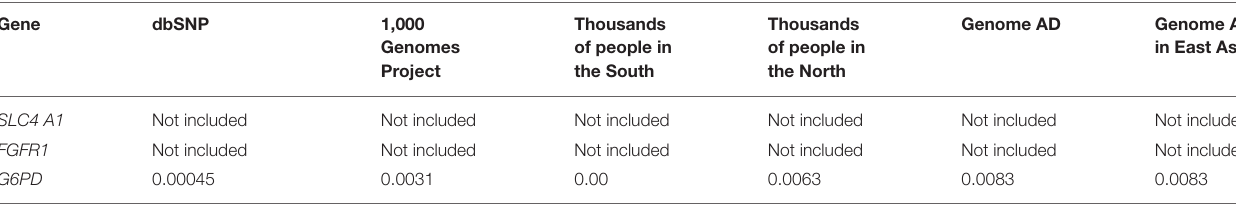
TABLE 4 | The inclusion status and frequency of the three “pathogenic” genes in the